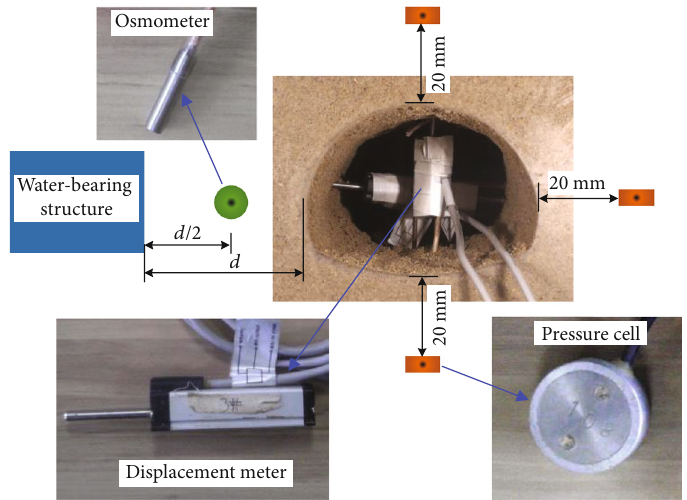
Figure 2: Sensor arrangement.